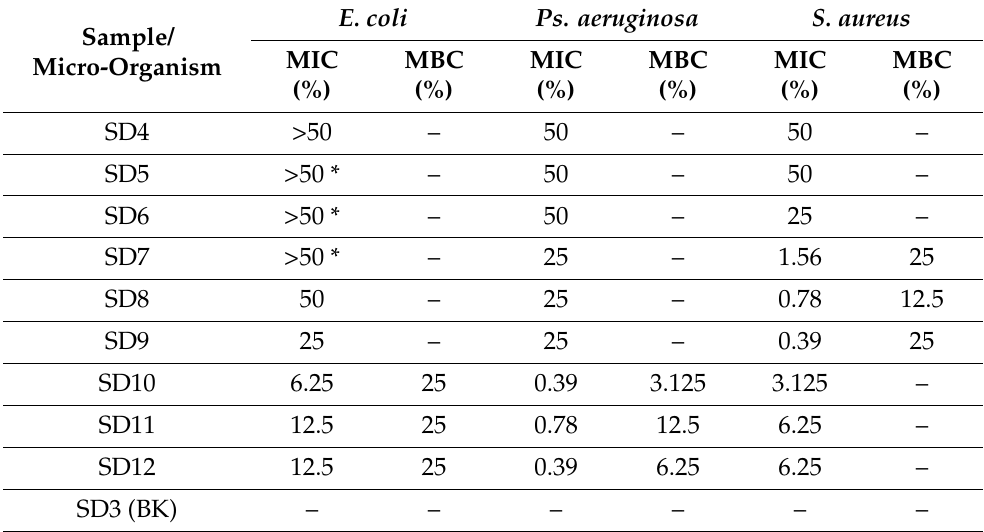
Table 4. Minimal inhibitory concentration (MIC) and Minimal bactericidal concentration (MBC).